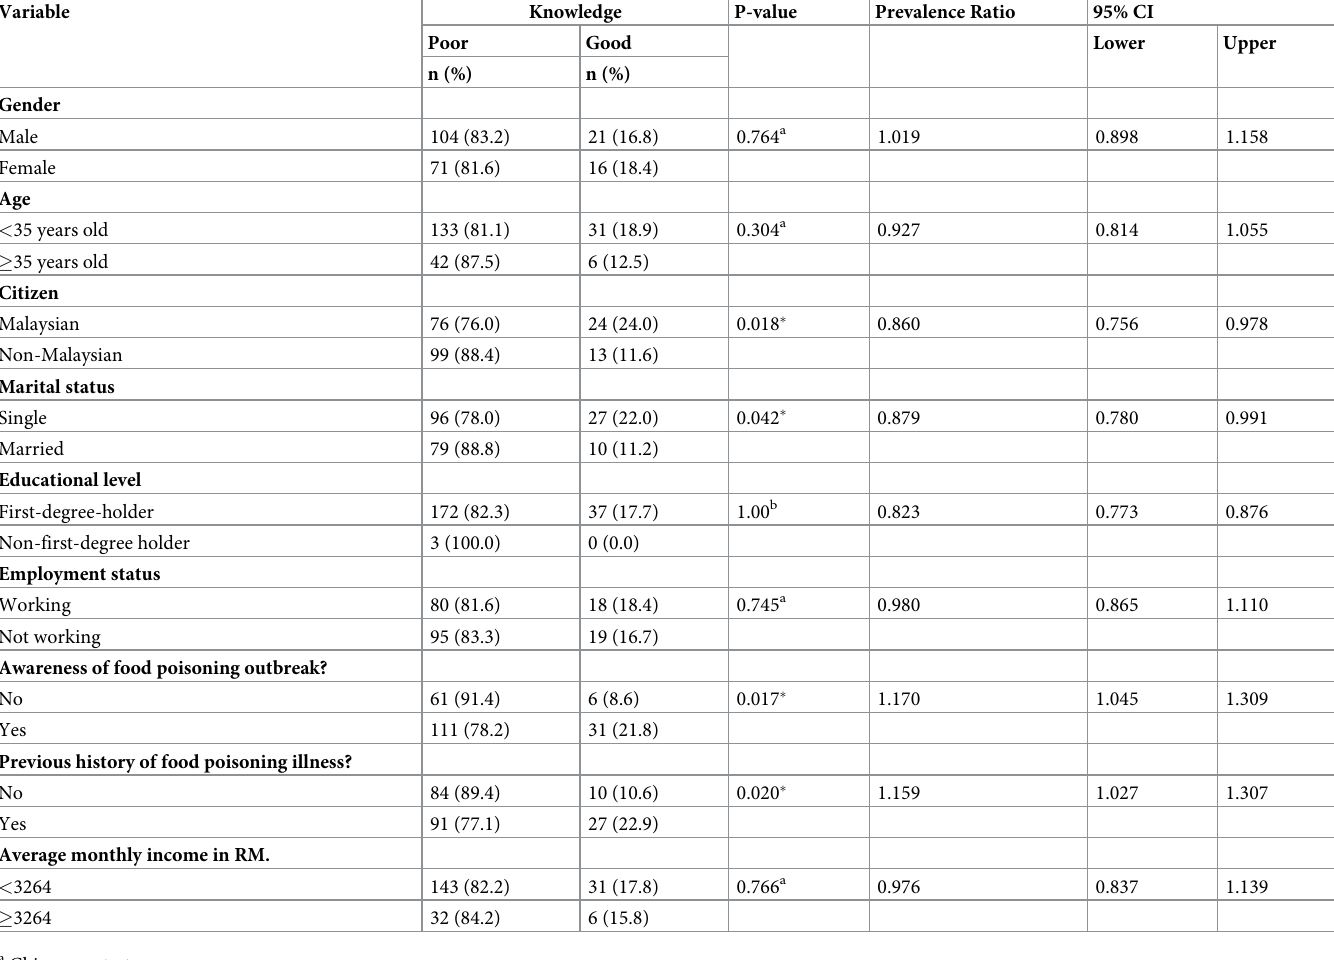
Table 7. Association between demographic and socioeconomic factors, awareness of food poisoning outbreak, and previous history of food poisoning illness with the knowledge of food poisoning (N =